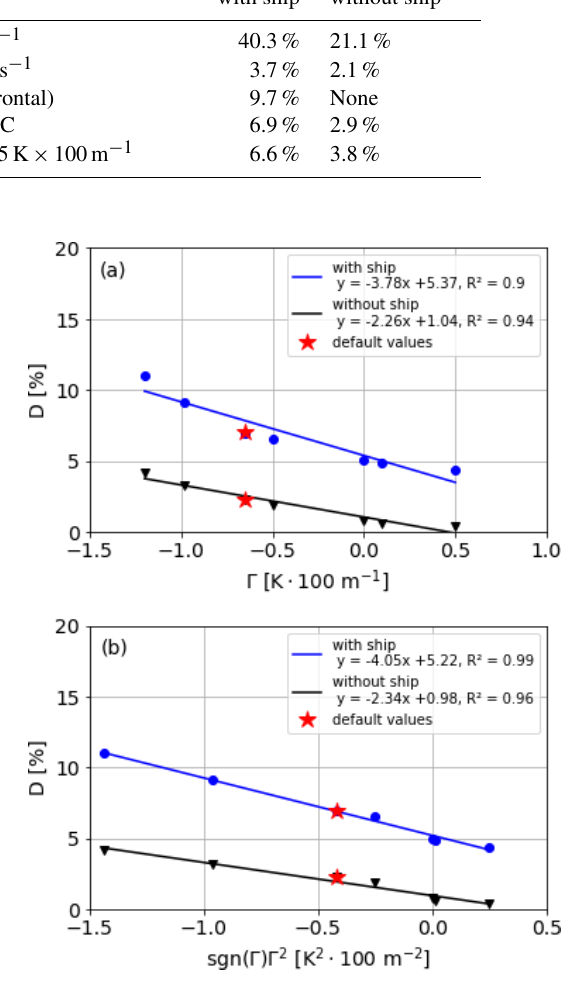
Figure 10. Dependence of the downward dispersion D on different vertical temperature gradients (cid:48) with and without the obstacle ef- fect. Linear regressions of the downward dispersion against (cid:48) (a) and sgn( (cid:48))(cid:48) 2 (b) are